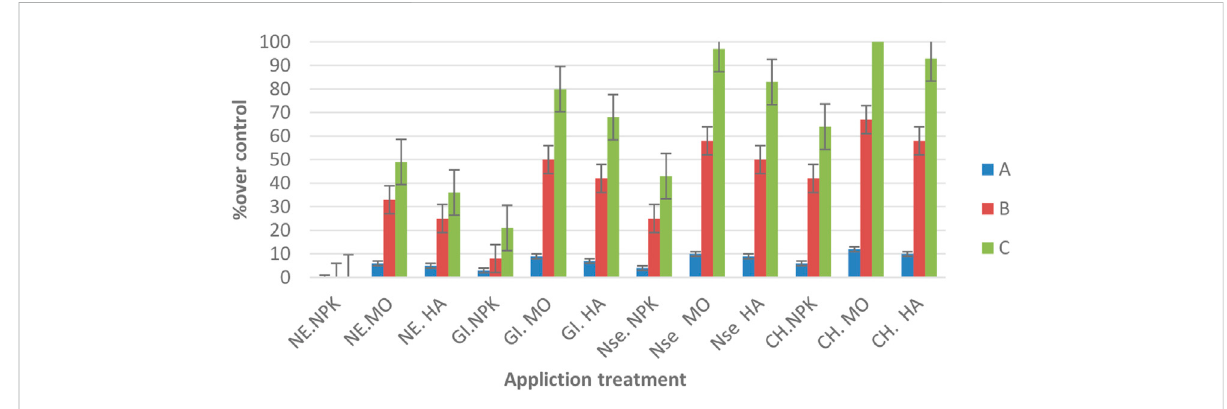
FIGURE 2 A: Total terpene NE constituents % over control, B: ART % constituents % over control, C: ARTY % over control.